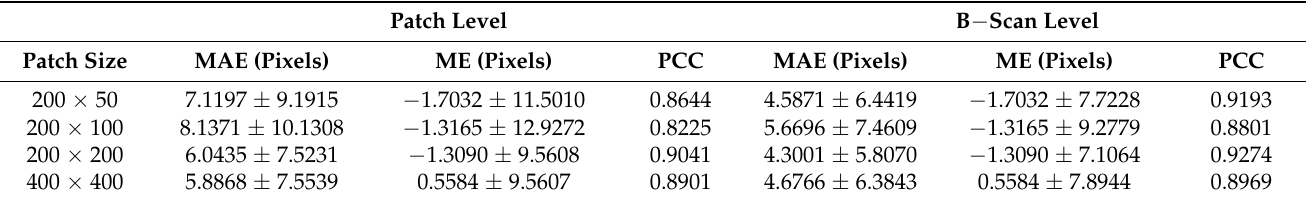
Table 1. The obtained results at patch and B-scan levels with different patch sizes. Patch